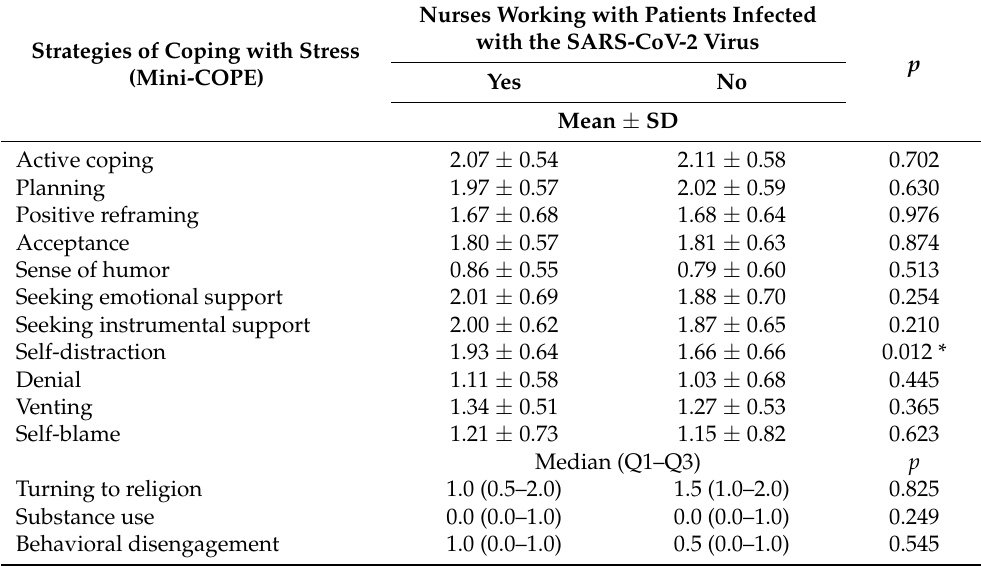
Table 3. Strategies of coping with stress used by nurses working with patients infected and those working with patients not infected with the SARS-CoV-2 virus.